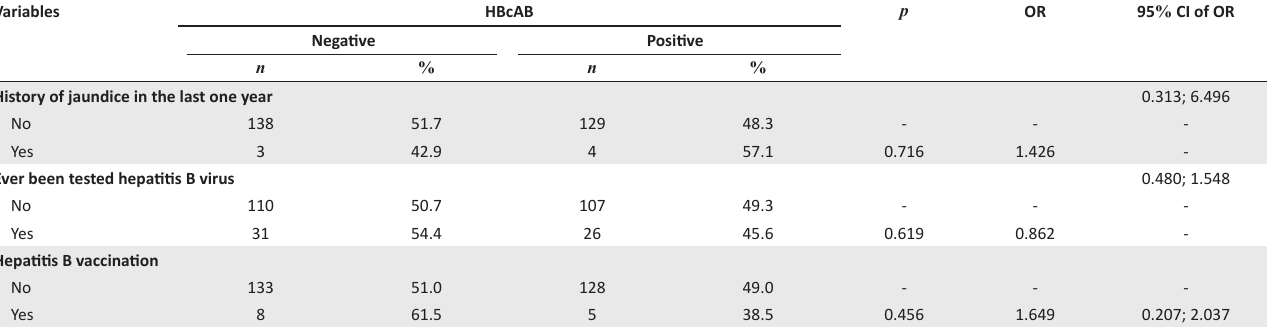
TABLE 2 (Continues...): Comparison of hepatitis B virus risk factors among anti-hepatitis B core-positive and -negative blood donors in Ibadan, Nigeria, between April and May 2019. Variables